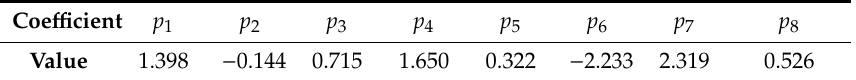
Figure 11. Stress components of the plates with angular misalignment under the axial tension.